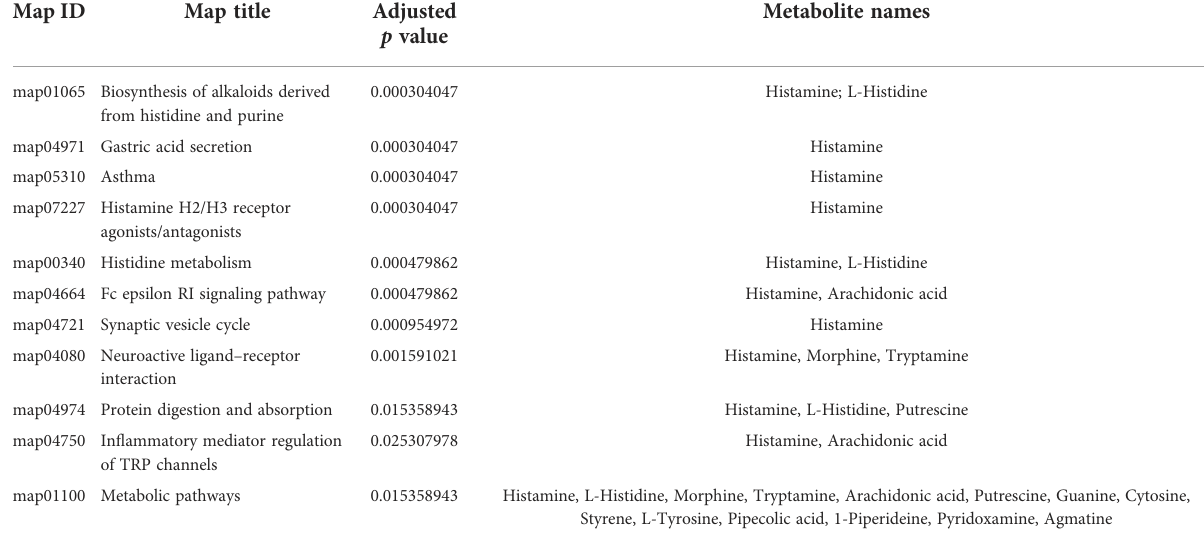
TABLE 5 KEGG pathways enriched by differentially expressed